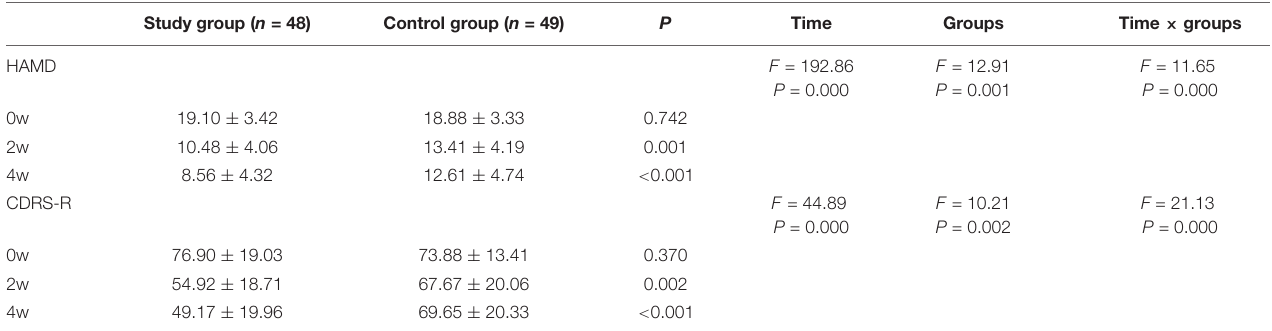
TABLE 2 | The effects of time and group variables on a total score on HAMD-17and CDRS-R. Study group ( n = 48) Control group ( n = 49) P Time Groups Time ×